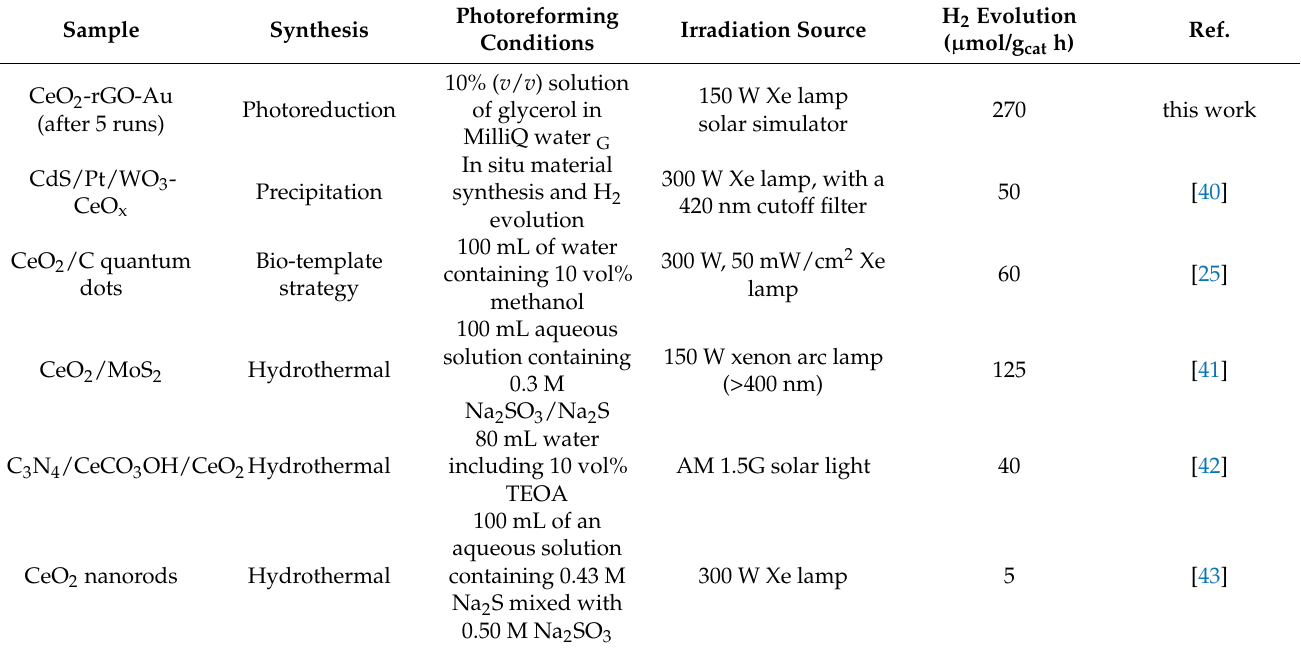
Table 3. Comparison among several CeO 2 -based systems used for the solar photocatalytic H 2 production.